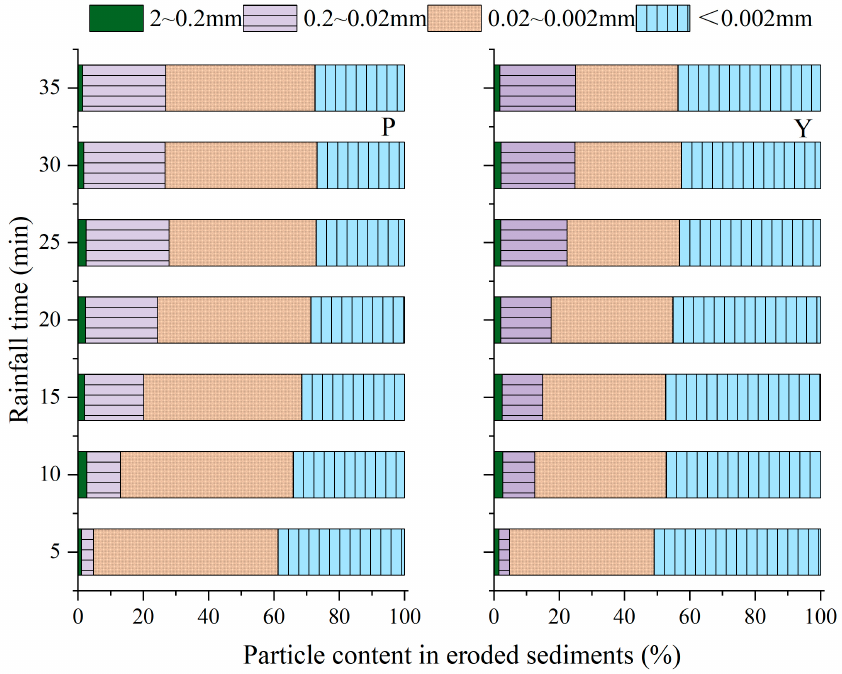
Figure 5. Particle content in eroded sediments with rainfall time at slope 15 ◦ and 3.0 mm min − 1 rain intensity.